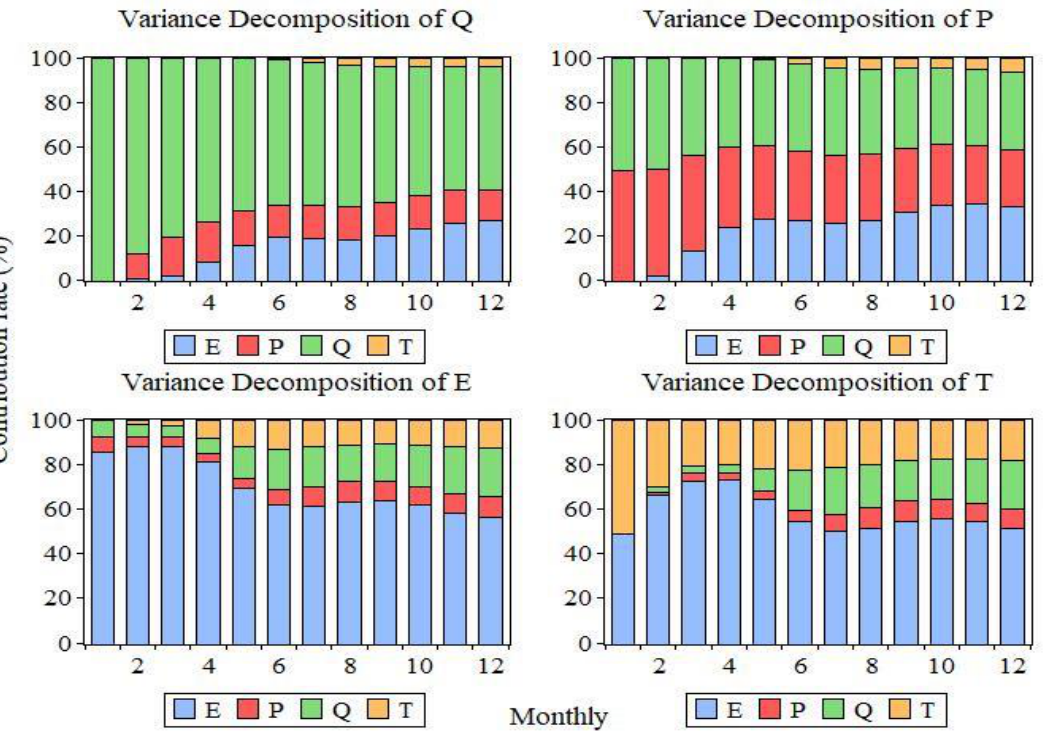
Figure 10. Mutual contribution rate of the four groups of hydro-meteorological factors.